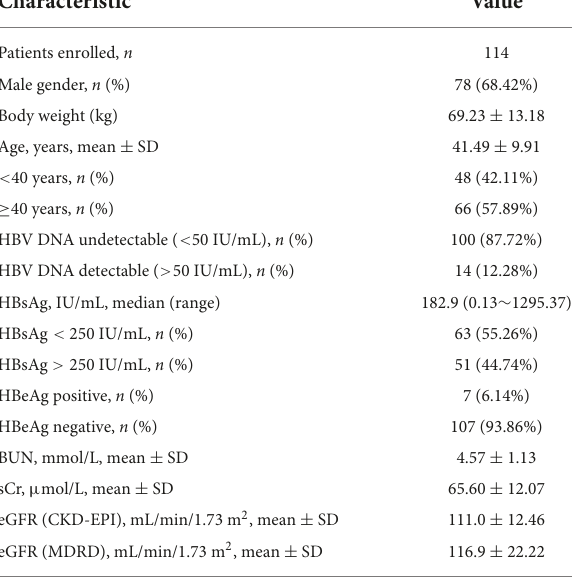
TABLE 1 Baseline characteristics of enrolled